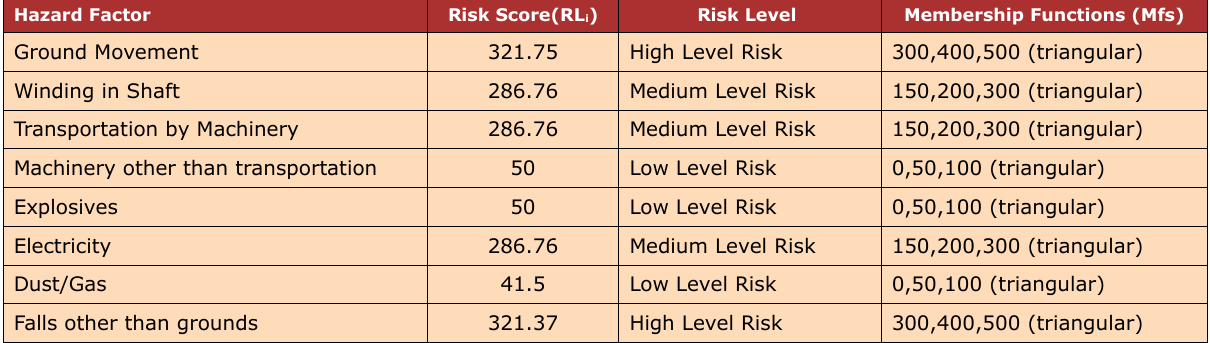
Table 7. Risk Level of Hazards obtained from